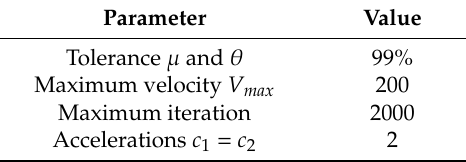
Table 3. Summary of important simulation parameters for PSO and simulated annealing